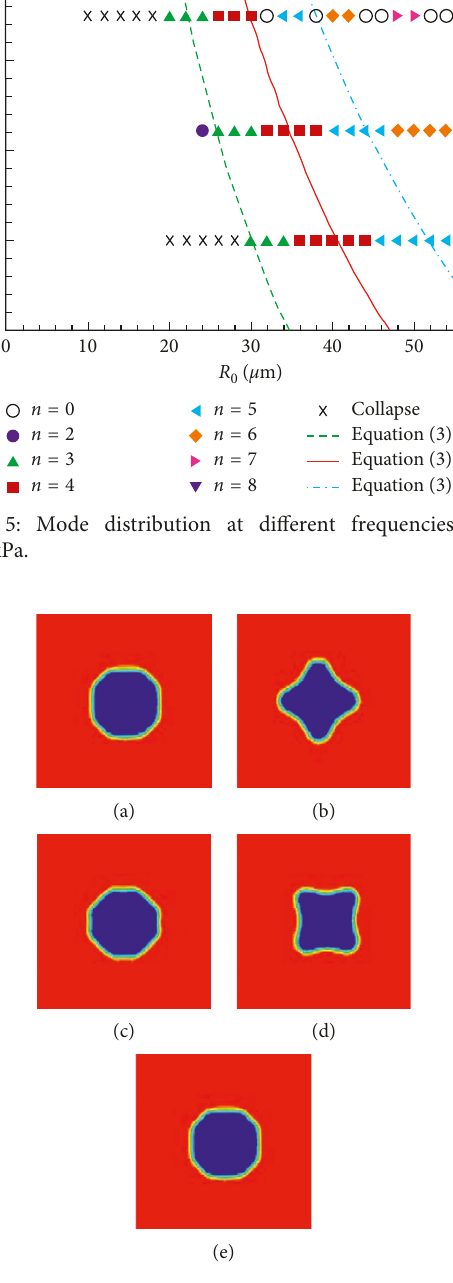
Figure 6: Shape oscillation of a microbubble in a single cycle at n � 4, when R 0 � 30 μ m, f � 130 kHz, and P d � 42kPa. (a) t ∗ � iT ; (b) t ∗ � ( i +0.5) T ; (c) t ∗ � ( i +1) T ; (d) t ∗ � ( i +1.5) T ; (e) t ∗ � ( i +2) T